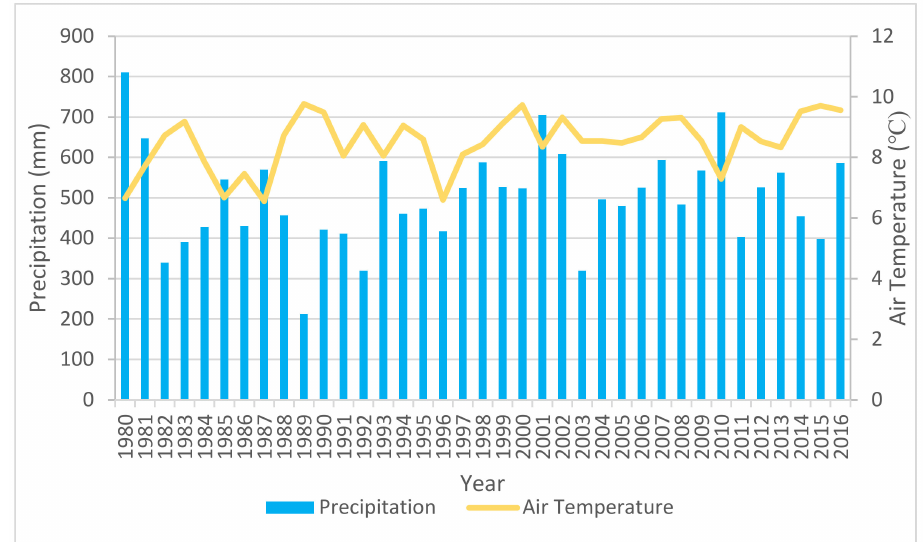
Figure 2. Average annual air temperature and average precipitation sums at the Kołuda Wielka meteorological station in the period of 1980–2016.